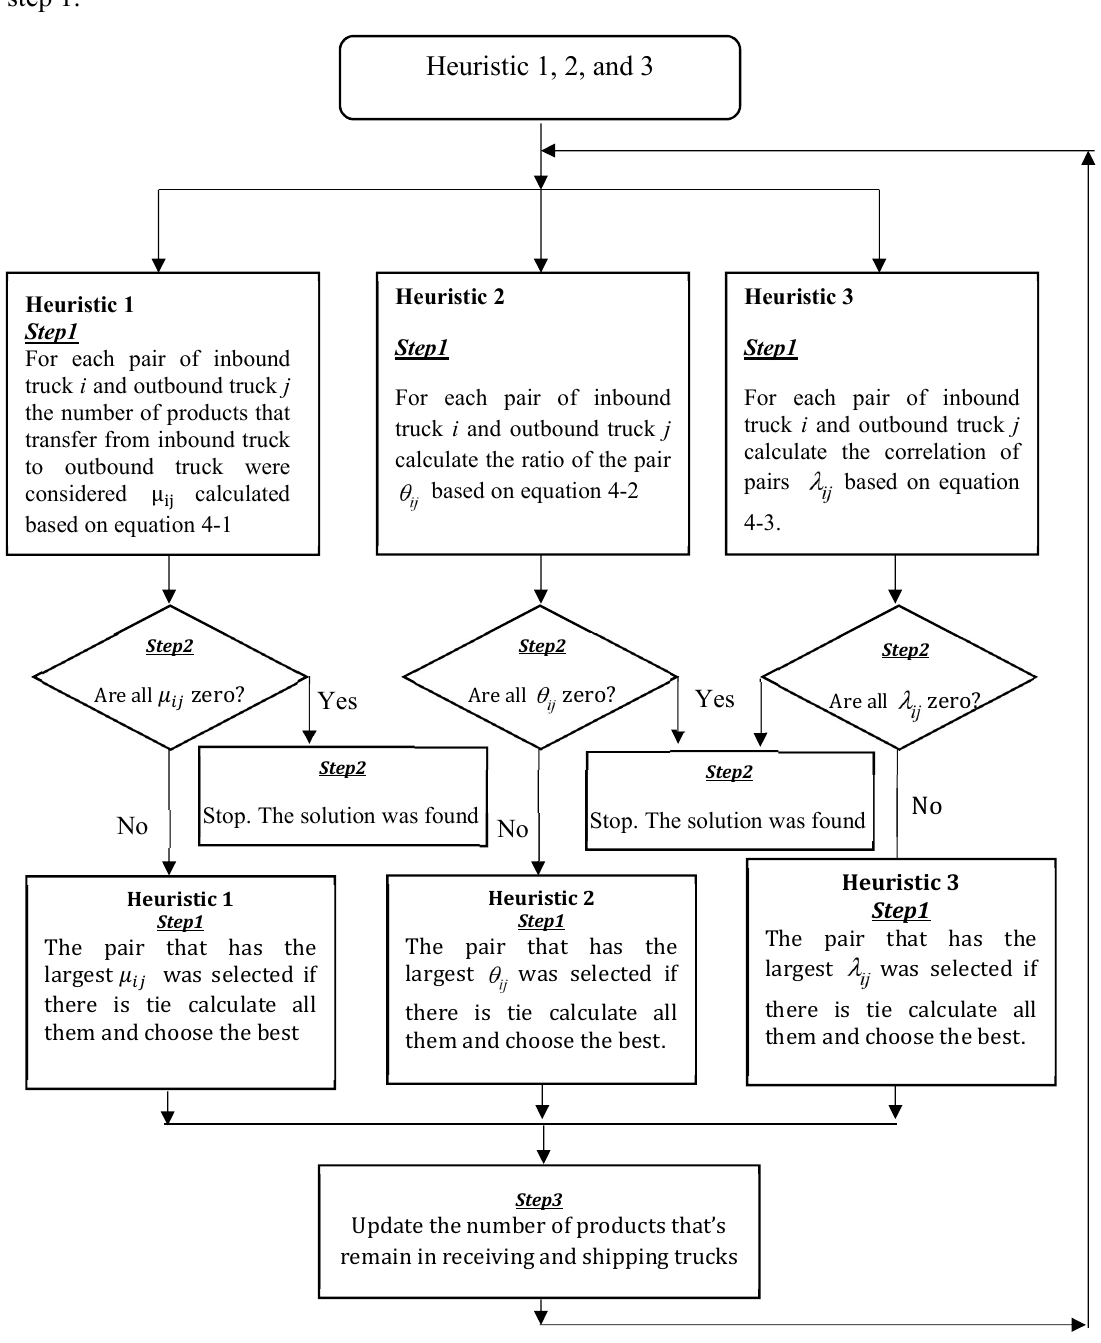
Fig. 2. Flowchart of the heuristic algorithm with SC 1, 2, and 3 adopted from (Yu & Egbelu,